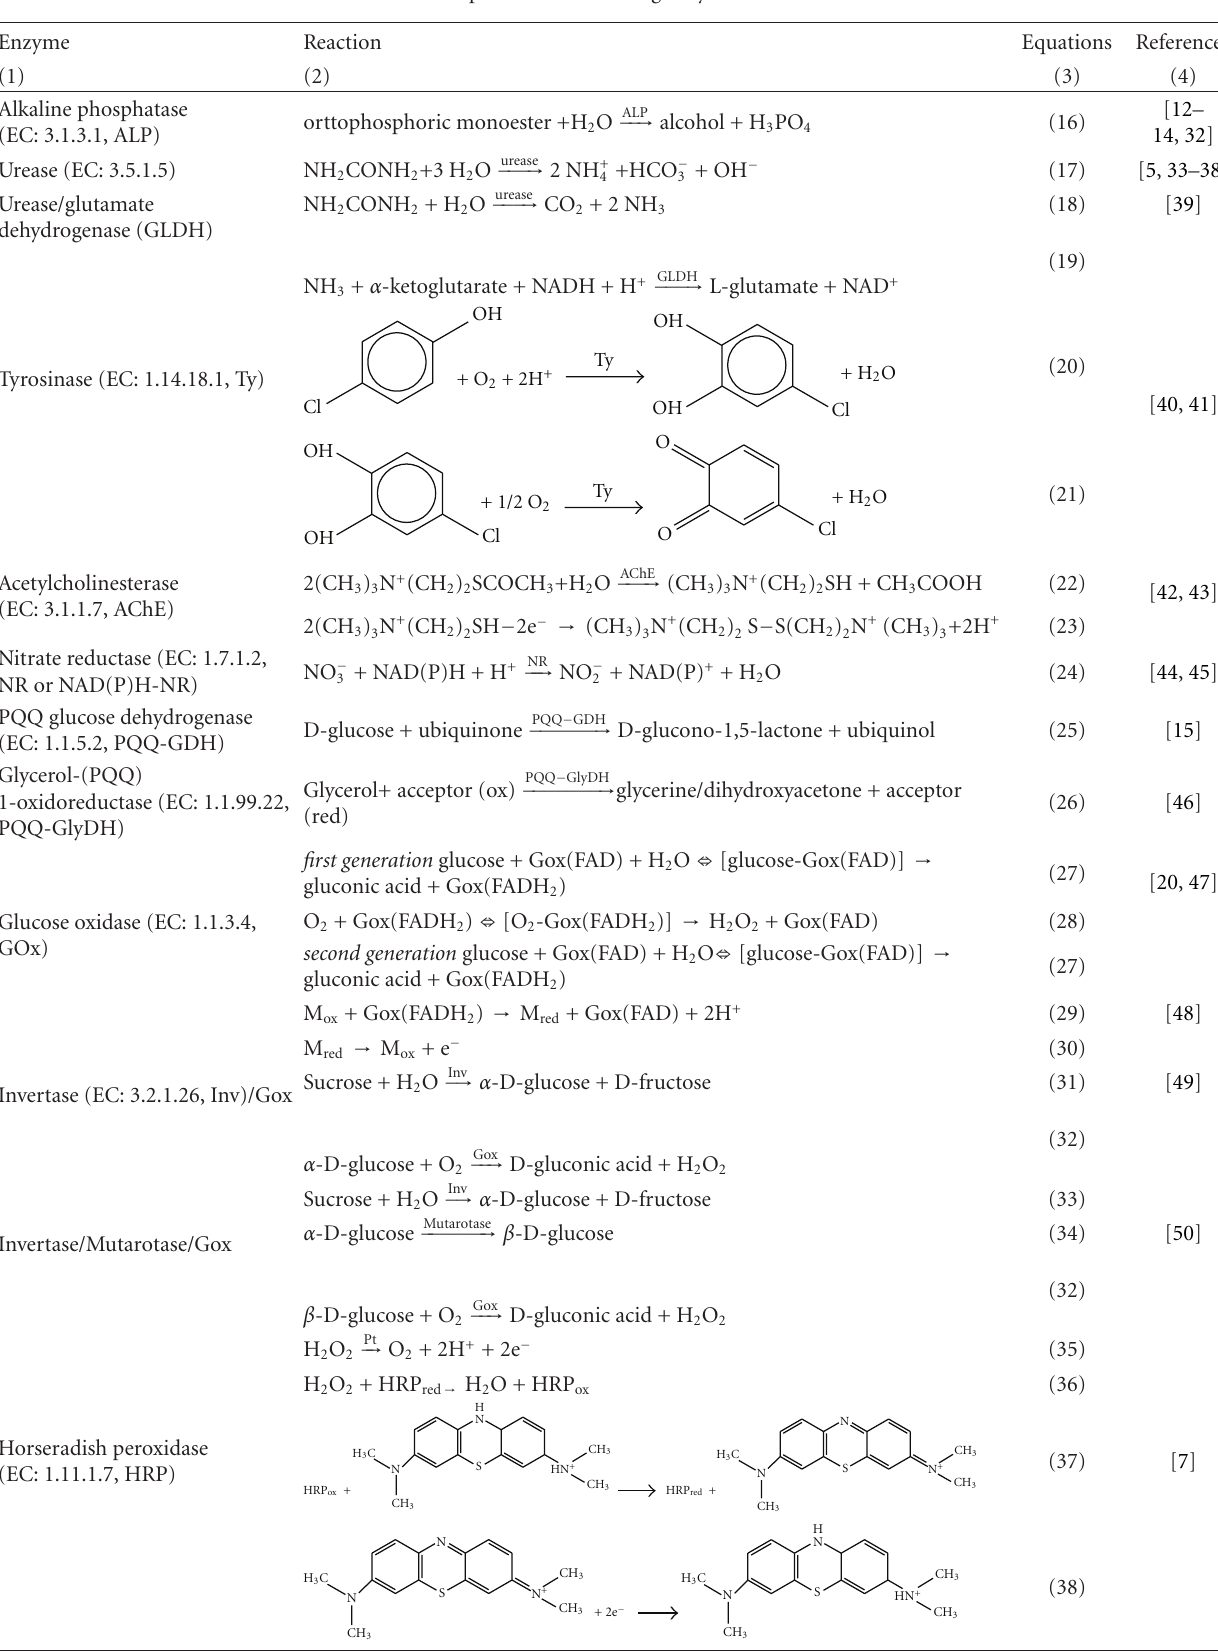
Table 3: Principle of detection using enzyme-based